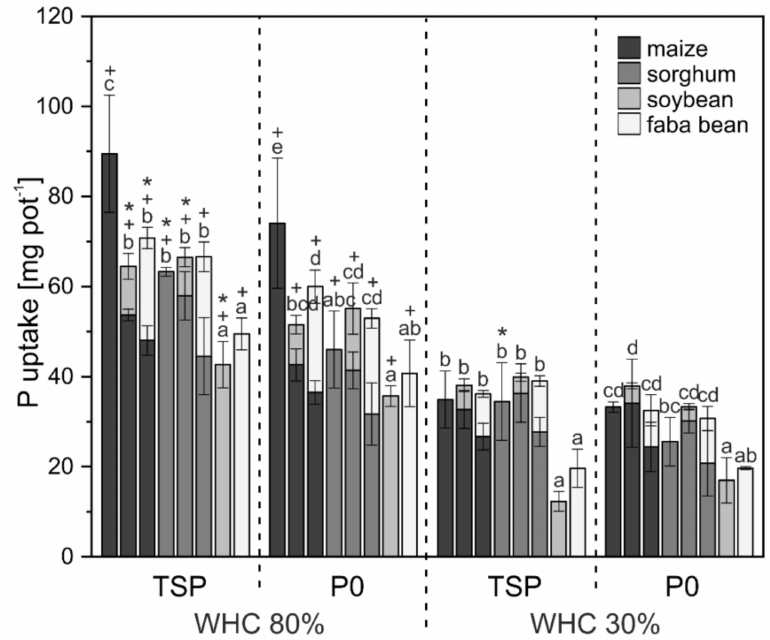
Figure 4. E ff ect of water supply and phosphorus supply on phosphorus uptake of the crops and mixtures in the Water-P-Trial (mean ± SD). Di ff erent letters indicate significant di ff erences between the crop variants at each water and P level, + indicates di ff erences between the water levels, * indicates di ff erences between the P levels (ANOVA and Duncan’s test, p ≤ 0.05). WHC = water holding capacity, TSP = triple-super P, P0 = control without P.